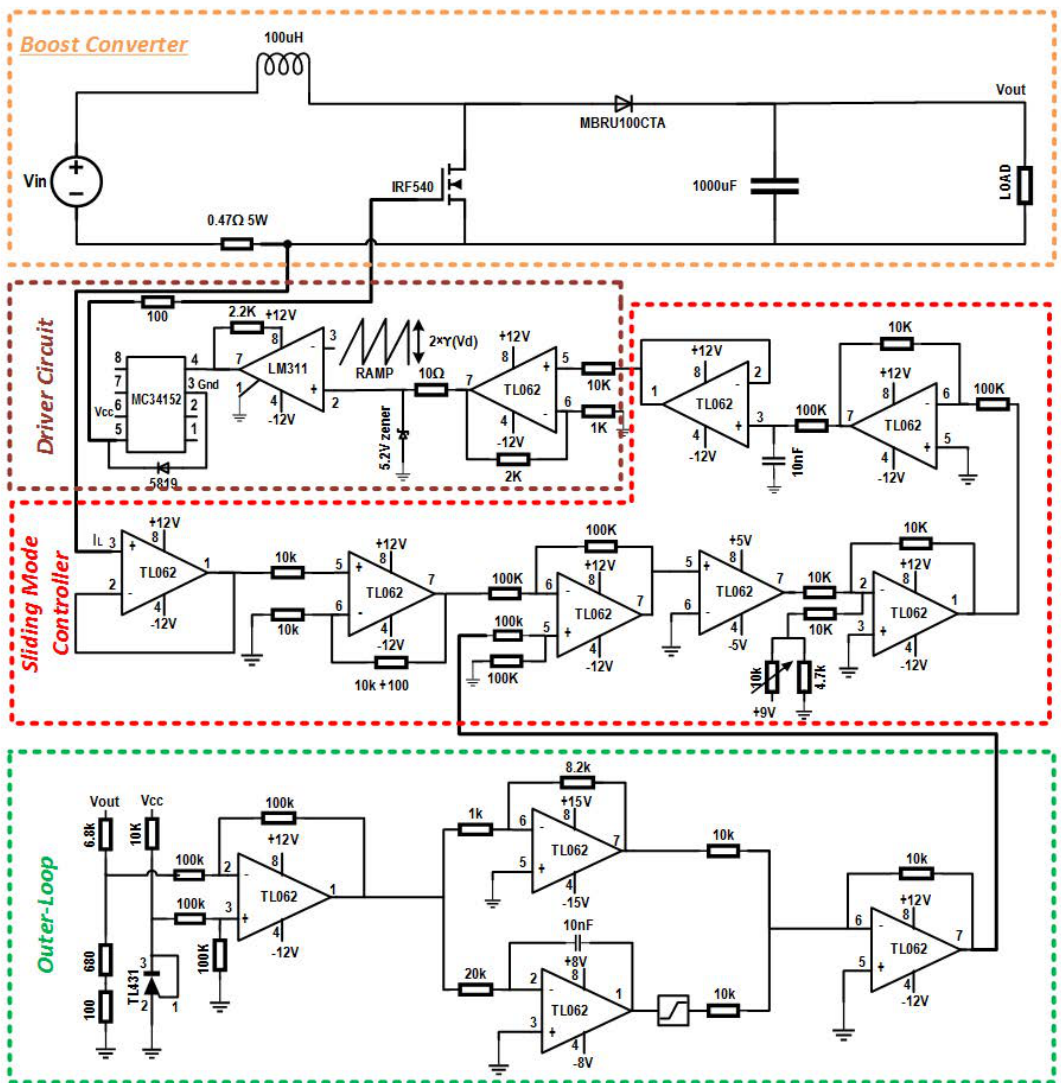
Figure 2. Complete circuit diagram of the proposed